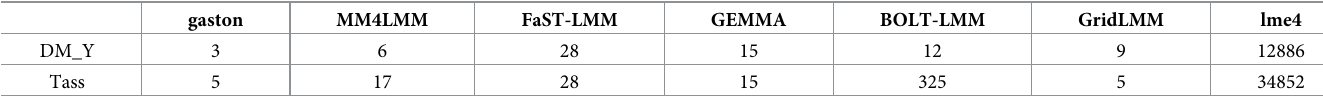
Table 1. Computational time (in sec.) associated to the different algorithms for the complete GWAS analysis of the Flint dataset, trait by trait.